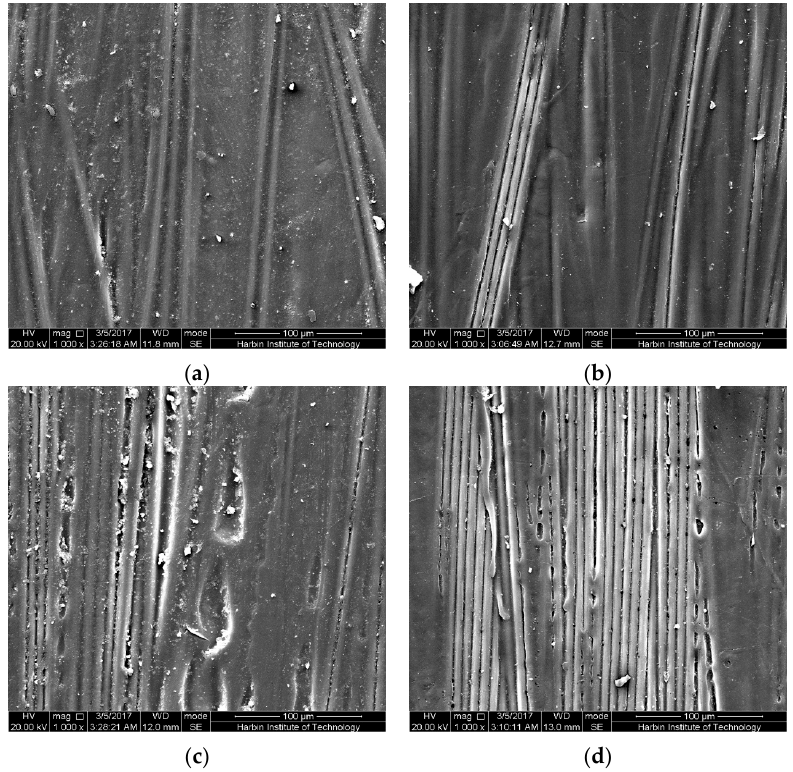
Figure 13. The bottom surfaces in the mid-span region of the epoxy-based CFRP samples after 6-month water immersion at 20 °C: ( a ) controlled samples, ( b ) the unstrained samples, ( c ) samples under 30% strain level, ( d ) samples under 58% strain level.